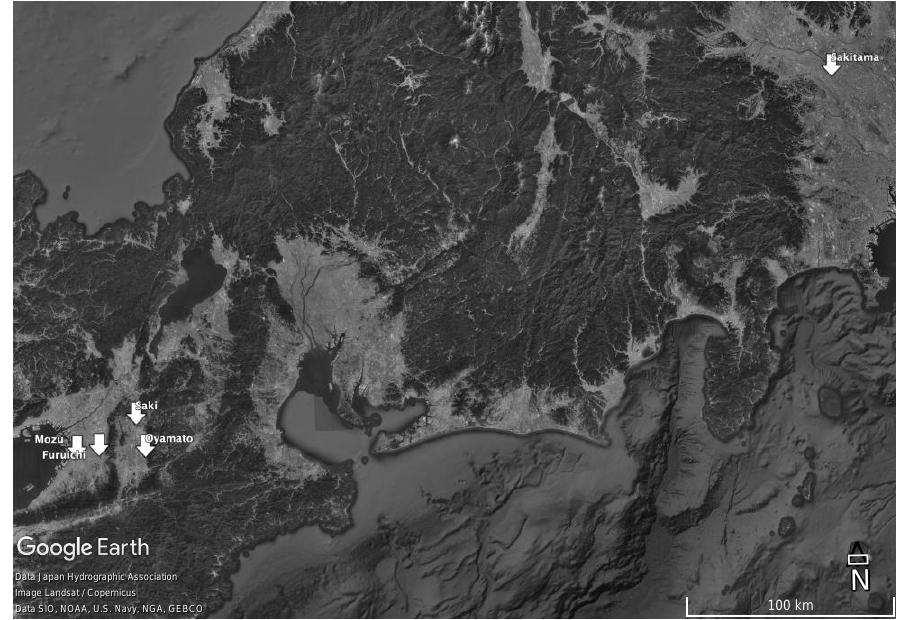
Figure 9. Location of the clusters (image courtesy of Google Earth).